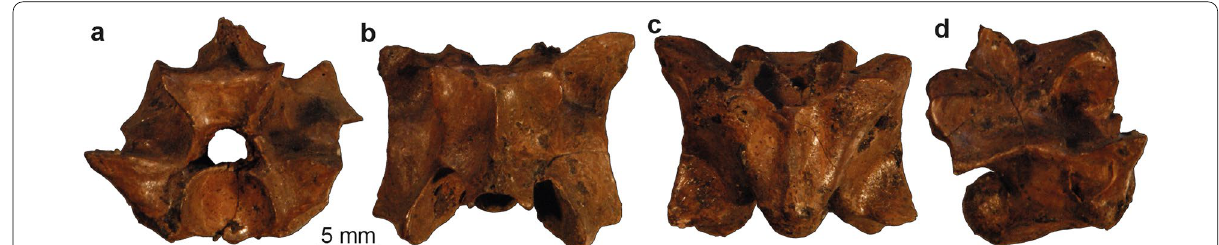
Fig. 22 Palaeopython ceciliensis from quarry XLI, Geiseltal: mid-trunk vertebra (GMH XLI-60a-1966) in anterior ( a ), dorsal ( b ), ventral ( c ), and right lateral ( d ) views